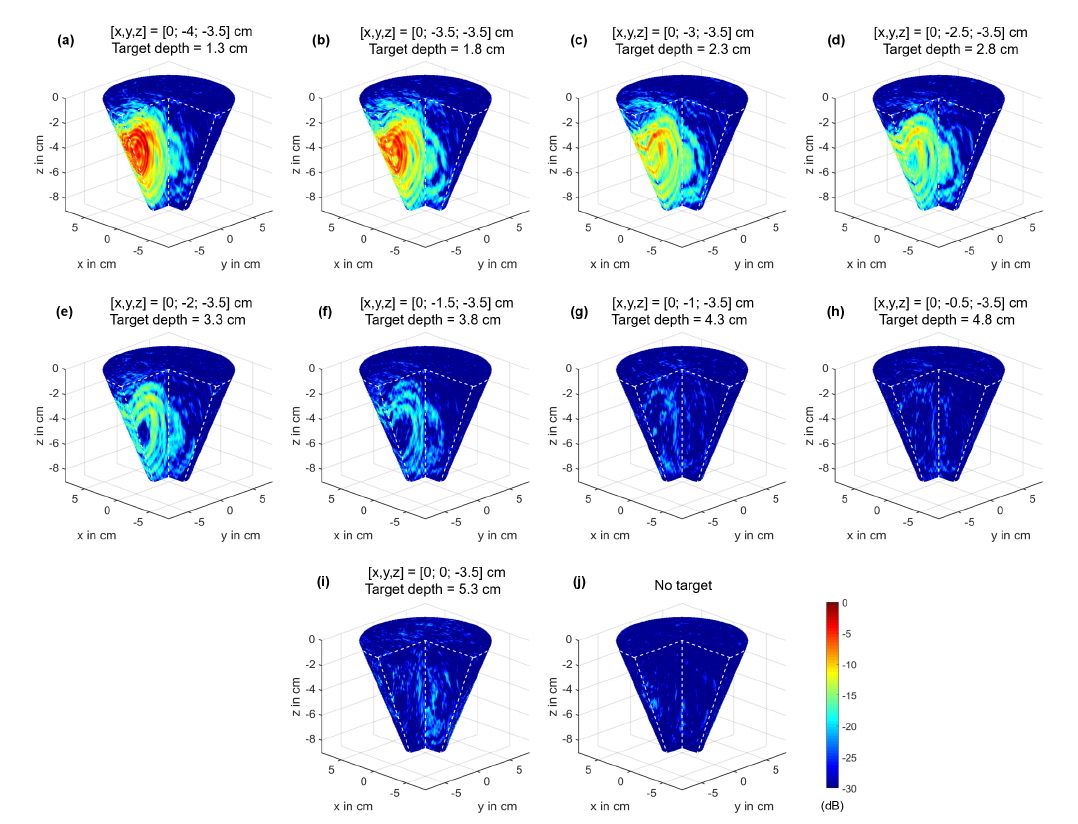
Figure 9. Imaging results of the 2mL target with an MNP concentration of 25mg/mL for different target positions. The images are normalized to the maximum intensity of Subplot ( a